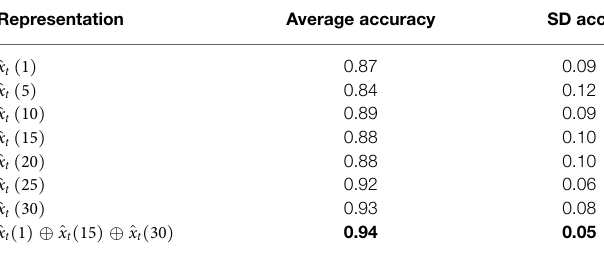
TABLE 2 | Average and SD accuracy of the temporal single-resolution representations and the best performing multi-resolution scheme . Representation Average